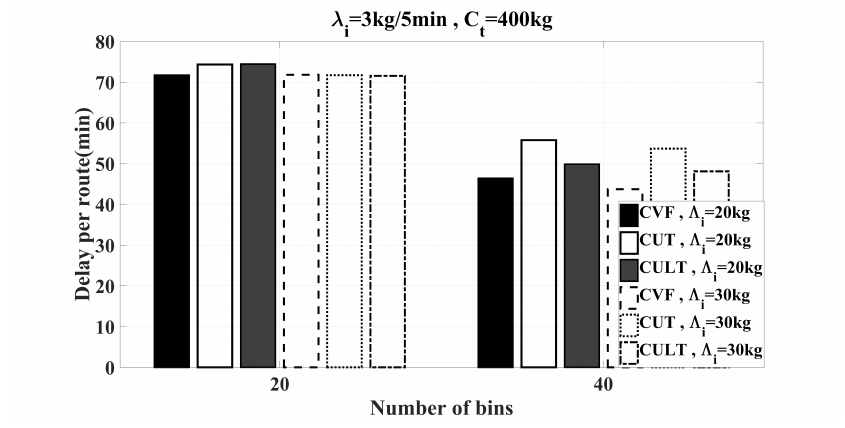
Figure 12. Delay per route: bin count when the bin capacity was increased.